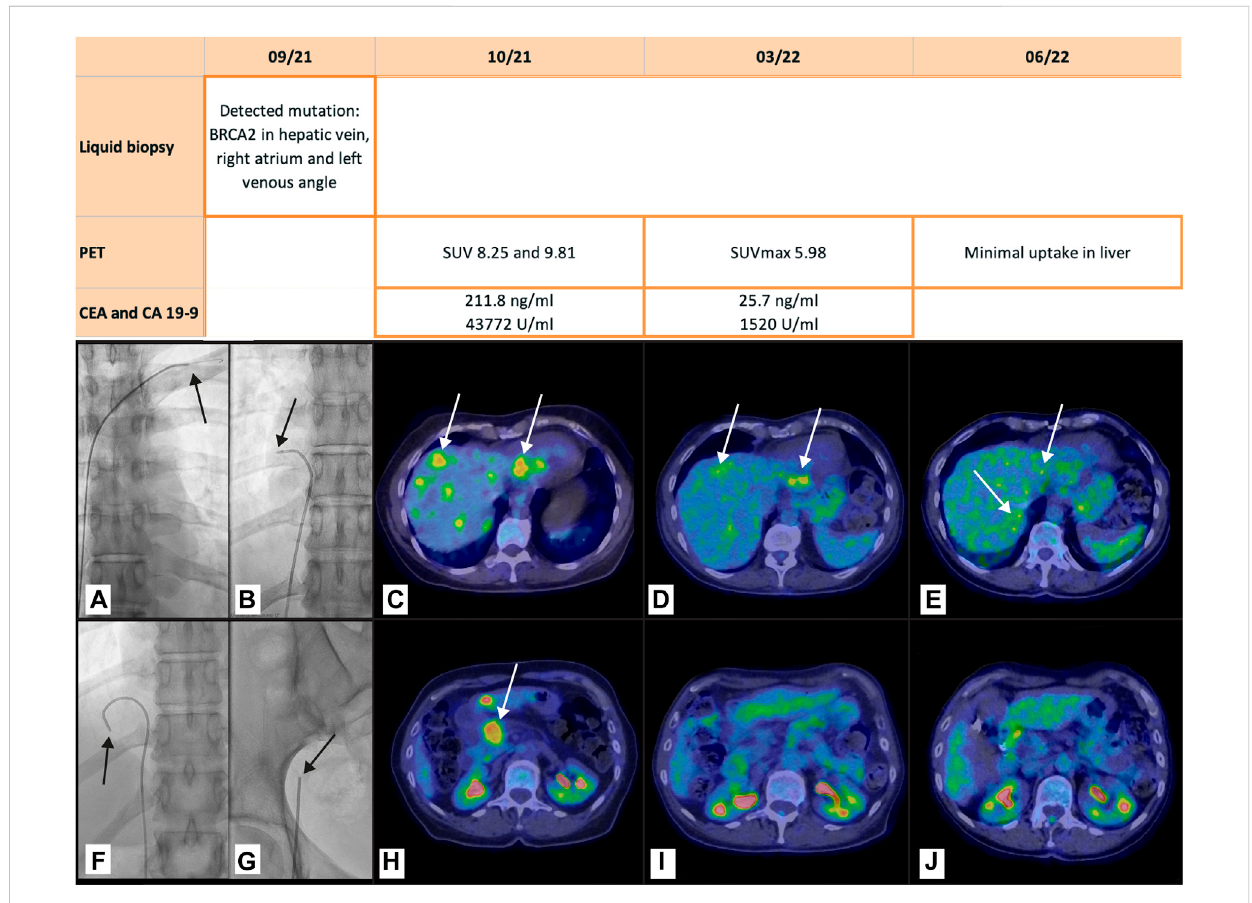
FIGURE 1 Pancreatic adenocarcinoma with liver metastases. The table shows the tests performed. The fi gure shows the radioscopic images of the catheter position (arrows) for selective venous sampling in the left venous angle (A) , in the right atrium (B) , and in the right hepatic vein (F) , and for peripheral sampling in the right femoral vein (G) . In the PET CT scan at staging (C, H) , 5 months later (D, I) and 8 months later (E, L) the arrows indicate the liver metastasesandtheprimarypancreaticcancerbeforetreatment (C,H) ,thetherapeuticresponseintheliver,wheresomelesions(arrows)remain